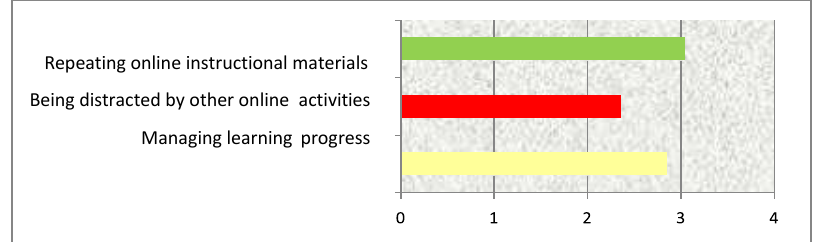
Figure 4. Students’ control in online learning